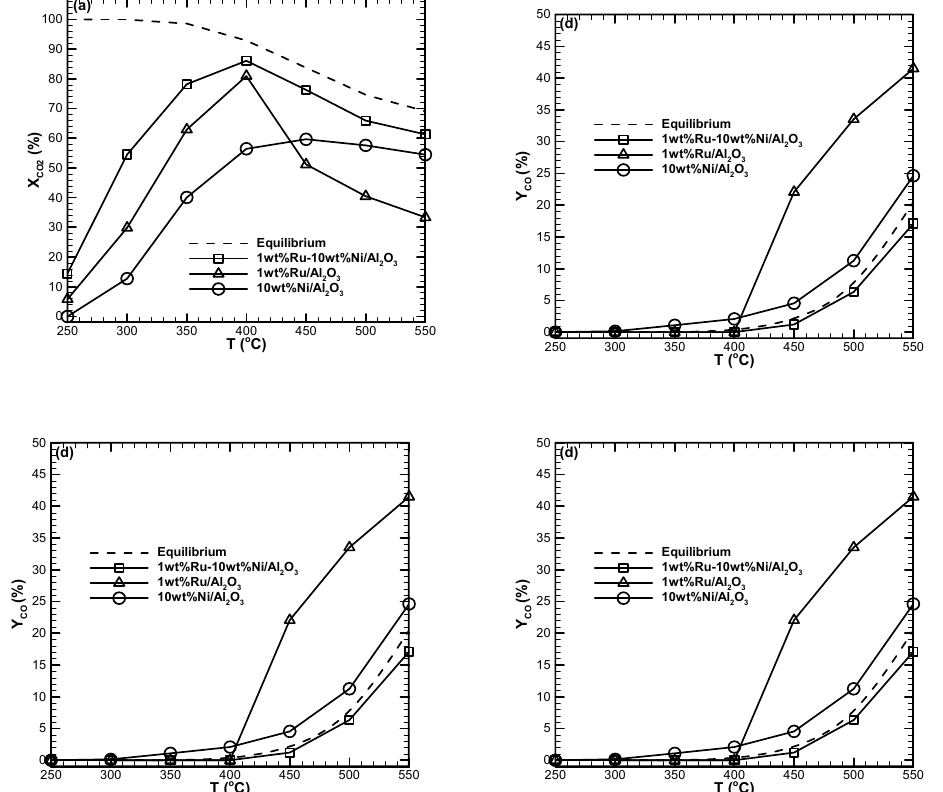
Figure 6. Averaged CO 2 methanation performance as a function of the temperature using 1 wt% Ru-10 wt% Ni / Al 2 O 3 catalyst based on time on stream measurement. ( a ) CO 2 conversion, ( b ) H 2 e ffi ciency, ( c ) CH 4 yield, and ( d ) CO